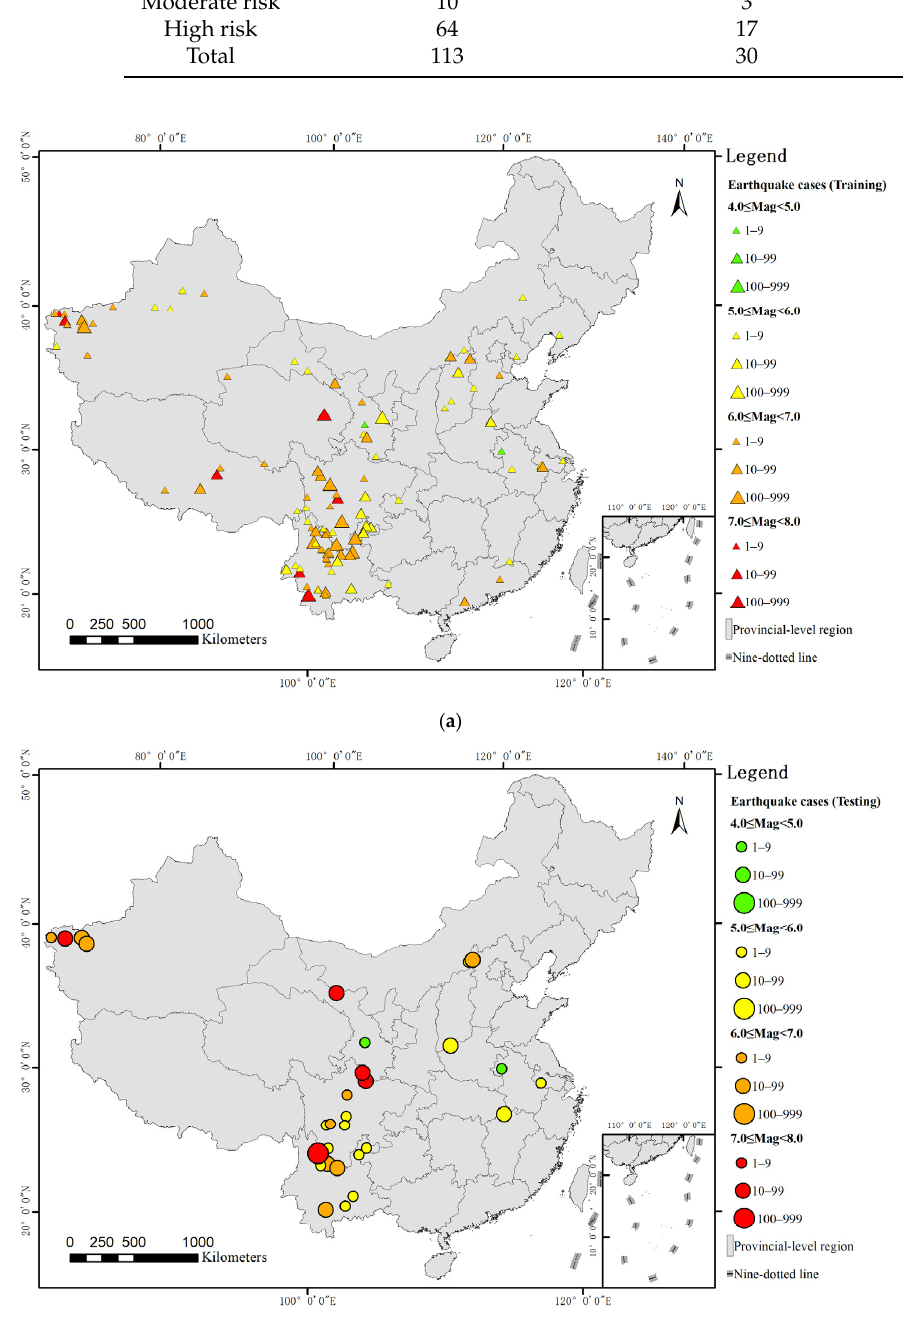
Figure 4. Spatial distributions of the earthquake case dataset: ( a ) Training samples; ( b ) testing samples.